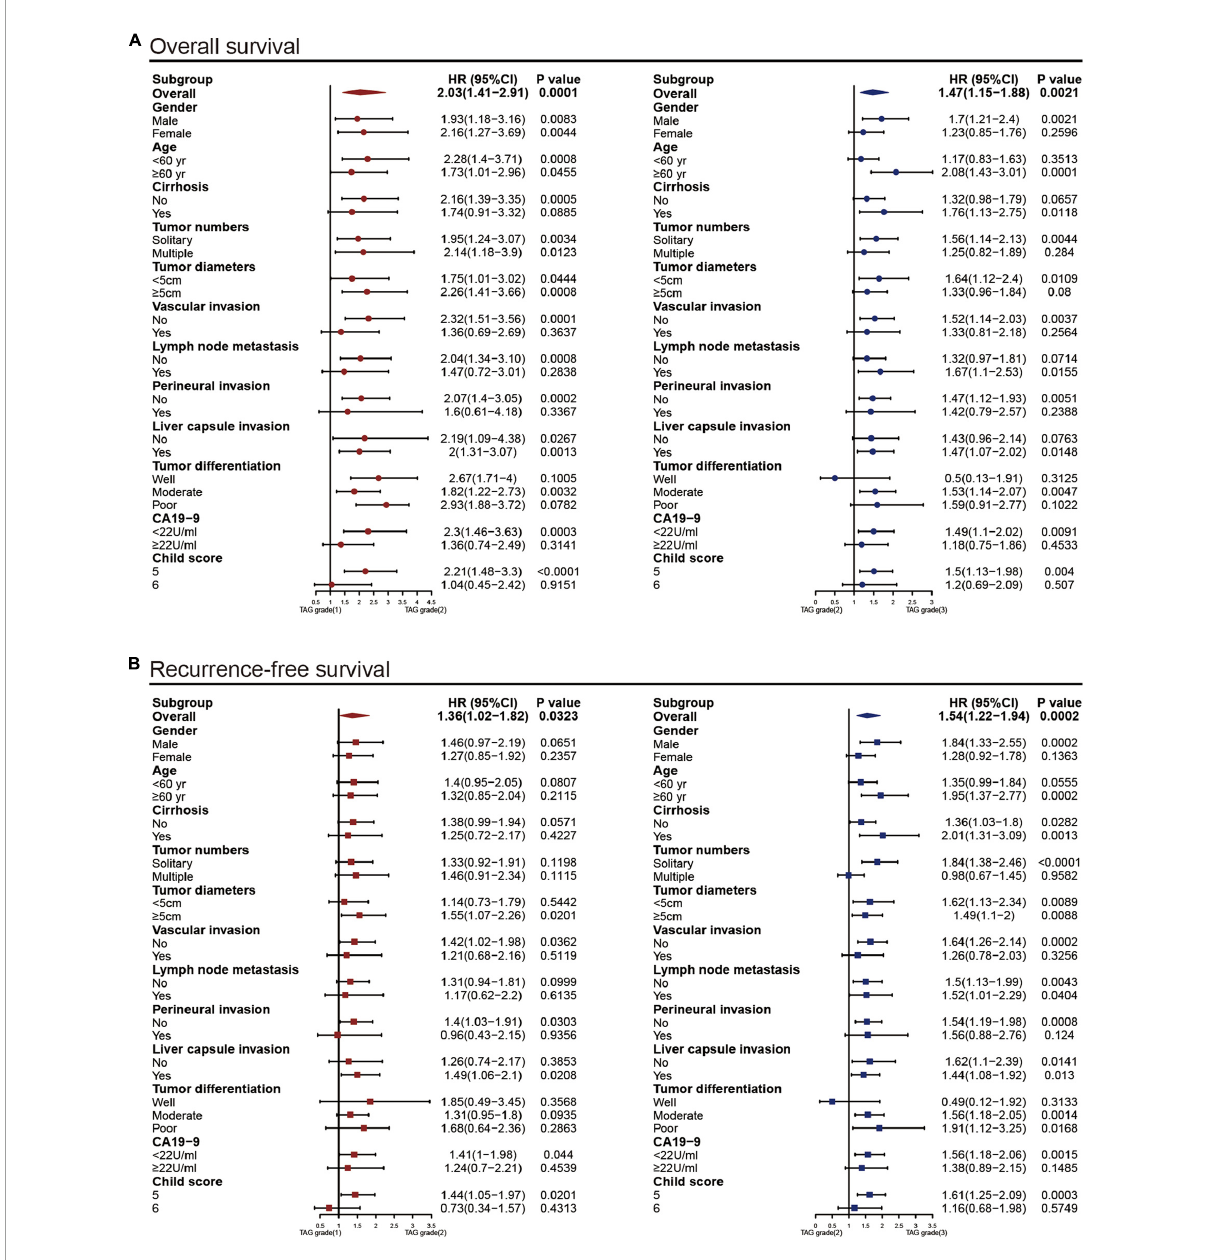
FIGURE4 Subgroup analyses to assess the discrimination ability of the TAG grade for overall survival (A) and recurrence-free survival (B) in patients with different clinical characteristics; HR, hazard ratio; CI, confidence interval; TAG grade, triglyceride-albumin-globulin